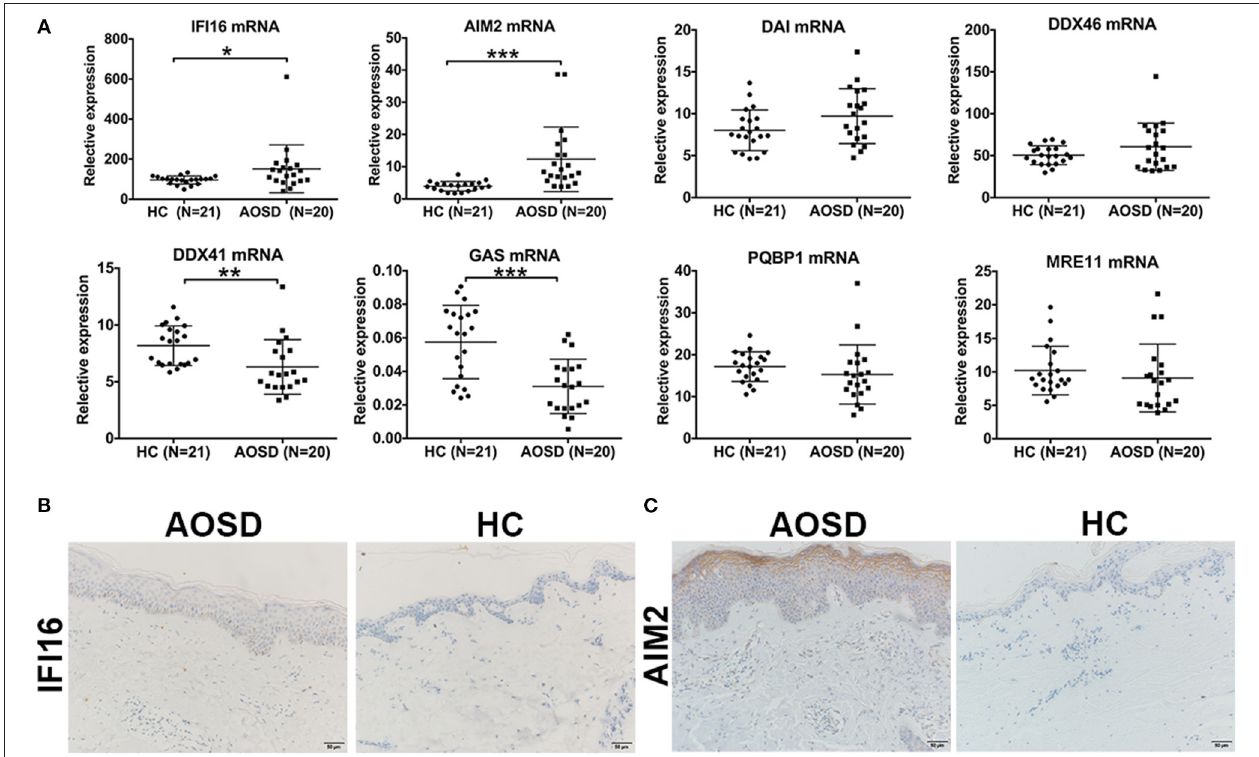
FIGURE 6 | Detection of DNA sensors in AOSD patients. (A) Comparison of diverse DNA-sensing receptors in AOSD patients and HCs. (B,C) Skin lesion tissue from an AOSD patient and a HC were stained with antibodies specific for IFI16 (B) and AIM2 (C) . Representative examples of immunohistochemical data (AOSD, N = 4; HCs, N = 4) are shown. Scar bar: 50 µ m. Original magnification: 200 ×